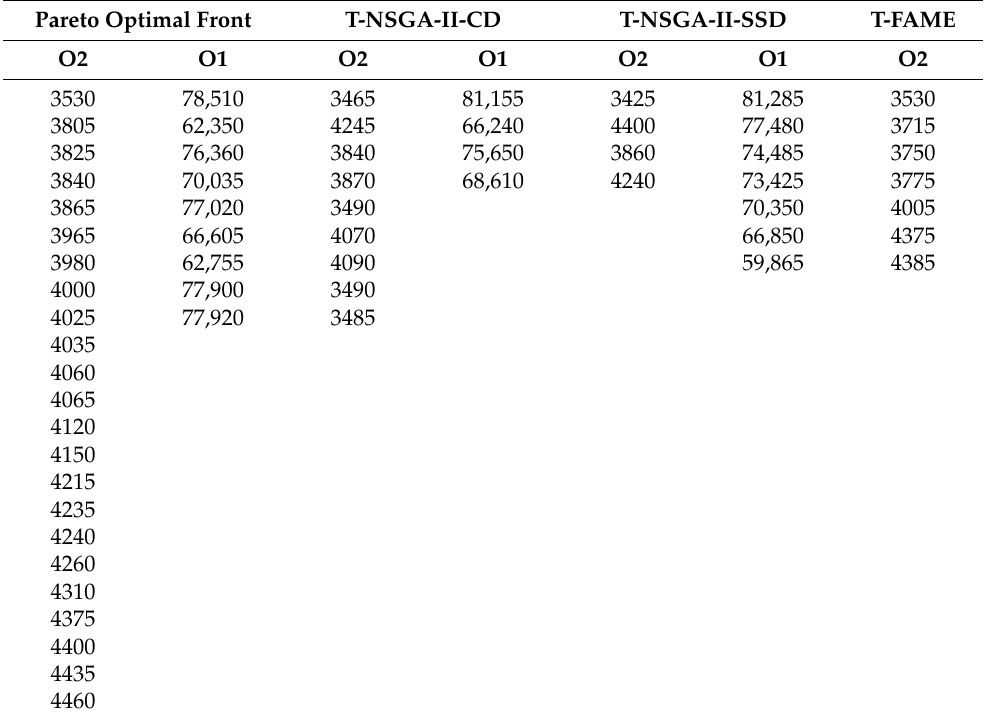
Table 5. Generated fronts of the algorithms with instance o2p25_rand.